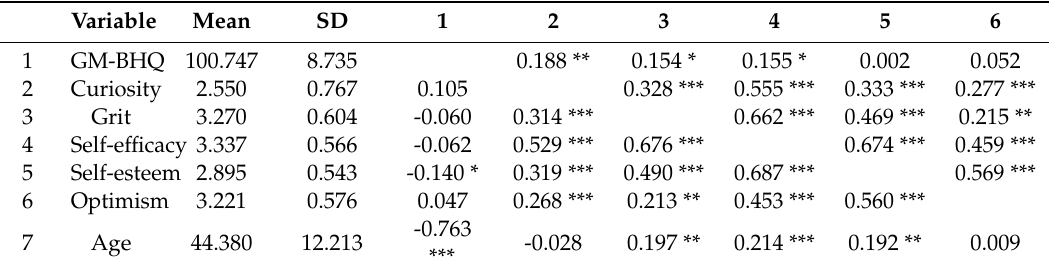
Table 4. Descriptive statistics and correlations.